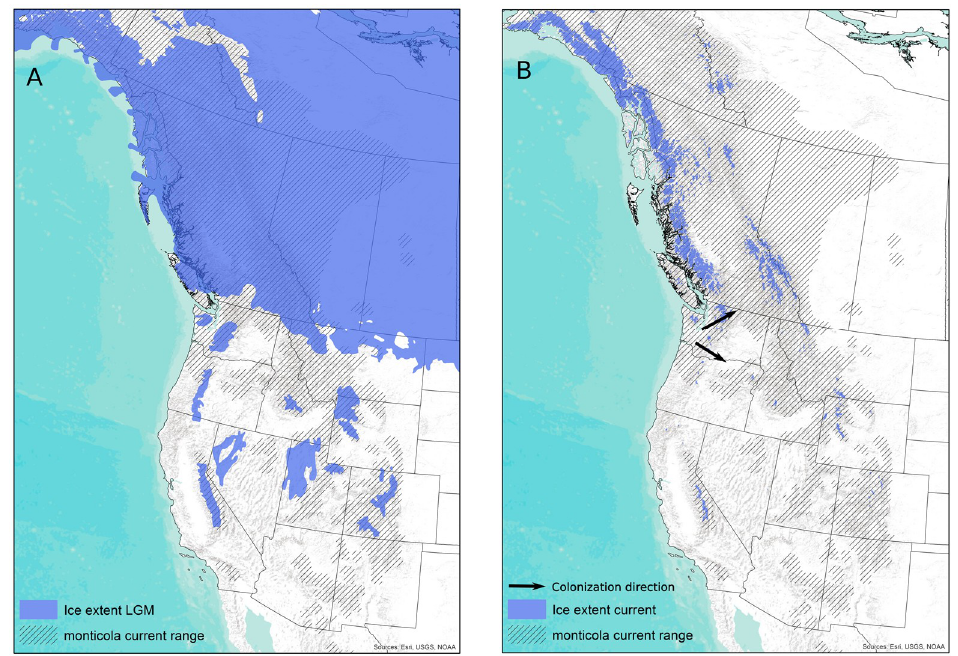
Figure 5. ( A ) Extent of ice sheets across western North America during the Last Glacial Maximum and the modern distribution of Sorex monticola . ( B ) Current glacial extent of western North America according to the Global Land Ice Measurements from Space (GLIMS) [52], modern distribution of Sorex monticola , and the hypothesized direction of post-glacial expansion of S. monticola to the North and